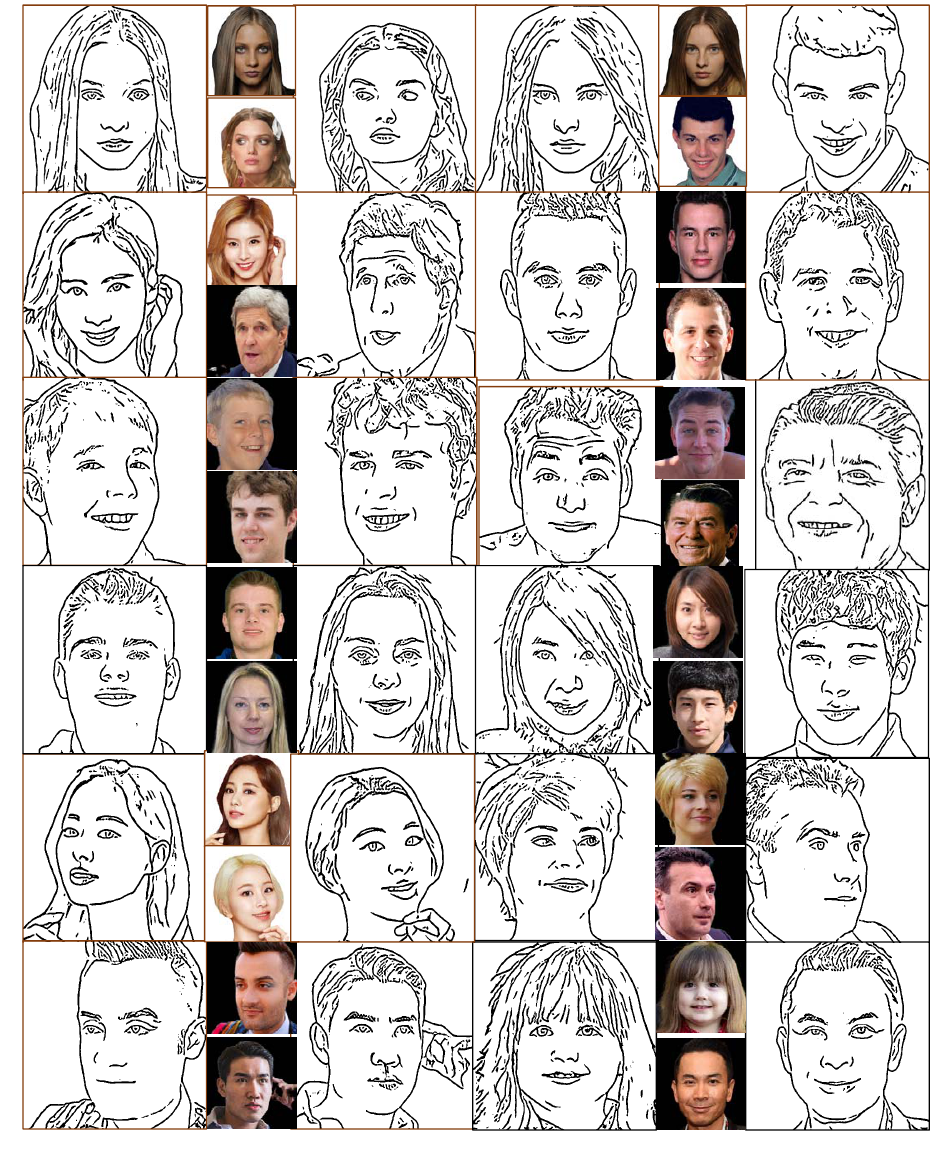
Figure 5. The result of the proposed